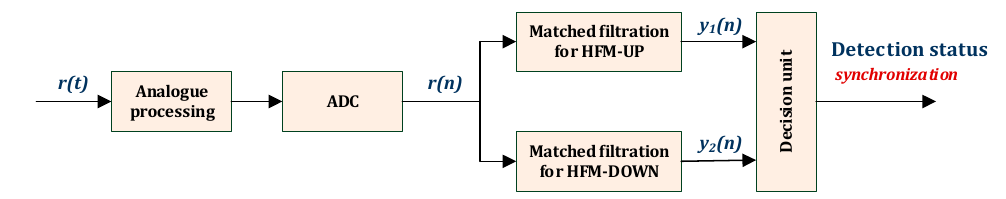
Figure 2. General scheme of receiving preamble signals.